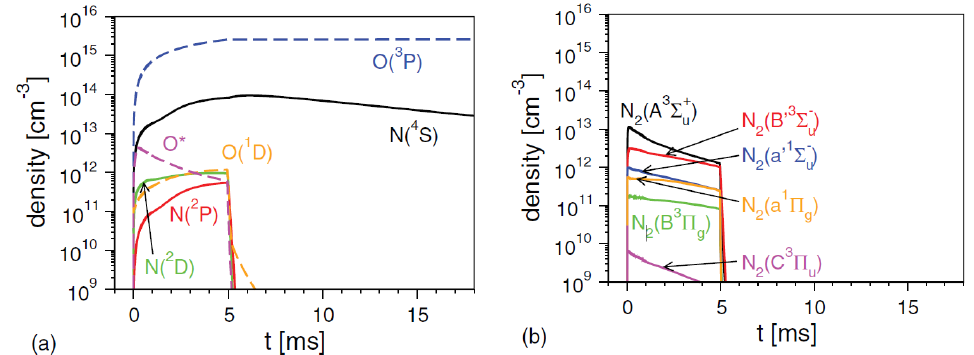
Figure 13. ( a ) Temporal evolution of selected atomic species and ( b ) of electronically excited nitrogen molecules for the case of a current of 150 mA [64], © IOP Publishing. Reproduced with permission. All rights reserved.